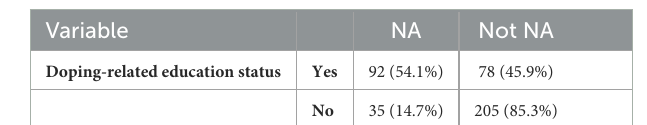
TABLE 1 Descriptive data of the sample ( n =